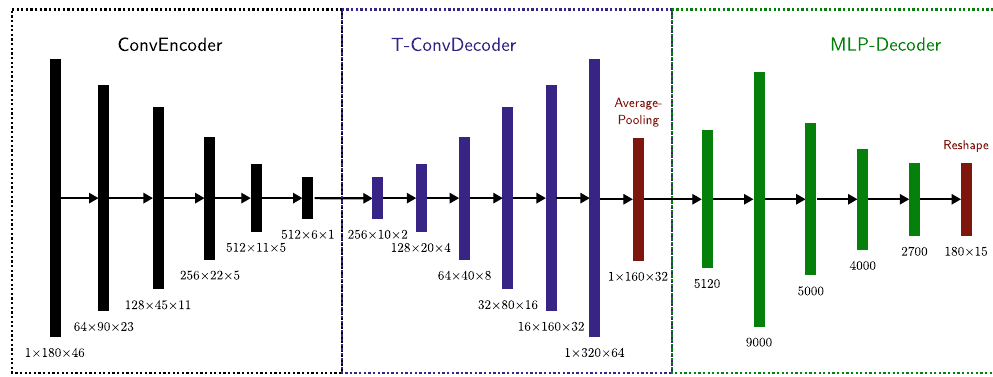
Figure 8. The basic reconstruction network architecture. It consists of three components: a convolutional encoder (ConvEncoder), transposed convolutional decoder (T-ConvDecoder), and a multilayer perceptron decoder (MLP-Decoder). The numbers show the dimension of output values per layer. We reshape the output of the MLP-Decoder to get the reconstructed unknown part of the pole plot for ψ max = 60 ◦